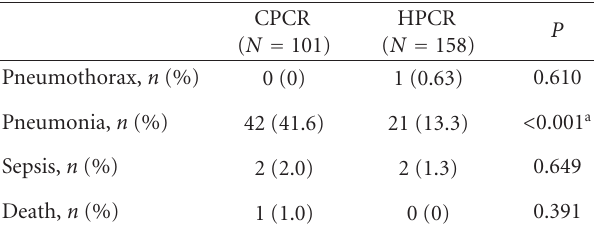
Table 3: Complications developed in newborns hospitalized in NICU with a RSV infection presenting a CPCR versus HPCR